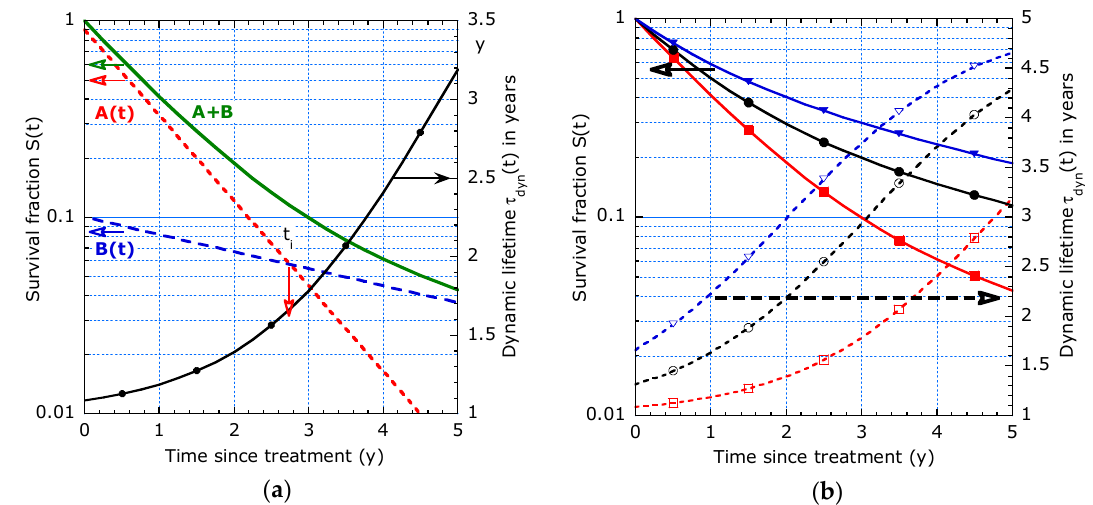
Figure 2. Example of the survival function (left scale) and dynamic lifetime (right scale) for the two- τ model with τ 1 = 1 y and τ 2 = 5 y: ( a ) Combined and separate subpopulations A ( p = 0.9) and B with intersecting survival at t i ; ( b ) Effect of different majority fractions with p = 0.5 (triangles), p = 0.7 (circles) and p = 0.9 (squares).